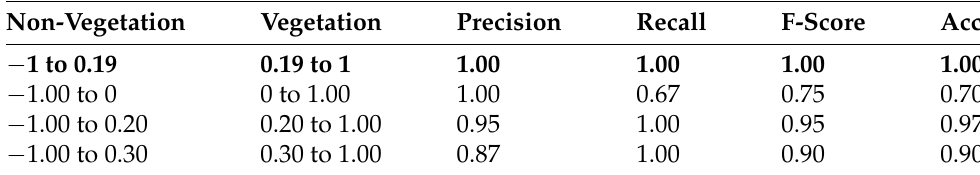
Table 7. Accuracy assessment for different threshold ranges at Level-1 classification for vegetation and non-vegetation regions. Note that each row represents the averaged metrics (Precision, Recall, F-score, and Accuracy) of four LGAs under Level-1 classification. The boldface represents the optimal threshold range and resulting best values.